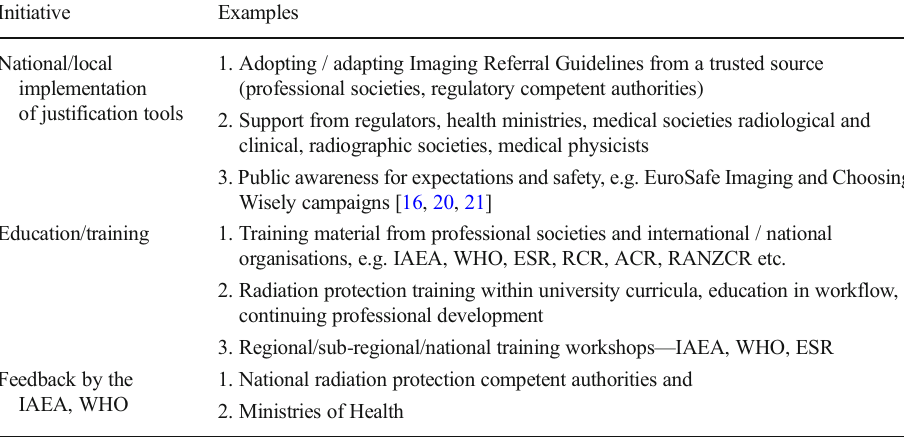
Table 4 Suggestions for the next steps forward Initiative